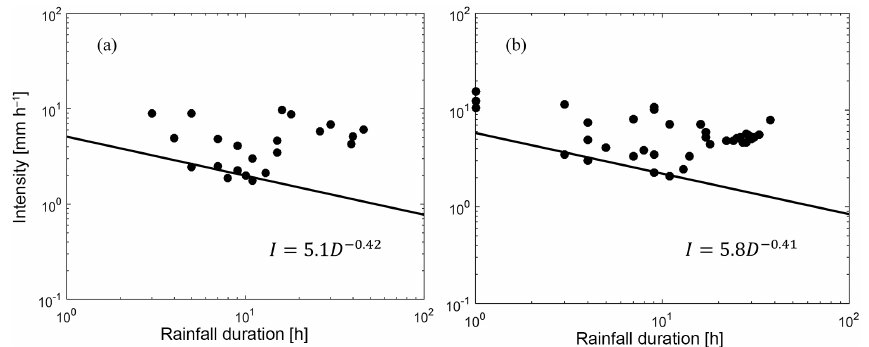
Figure 12. Intensity–duration thresholds (black line) derived from (a) rain gauges nearest to debris flow locations and (b) radar rainfall estimation at the same location of the rain gauges nearest to the debris flow.